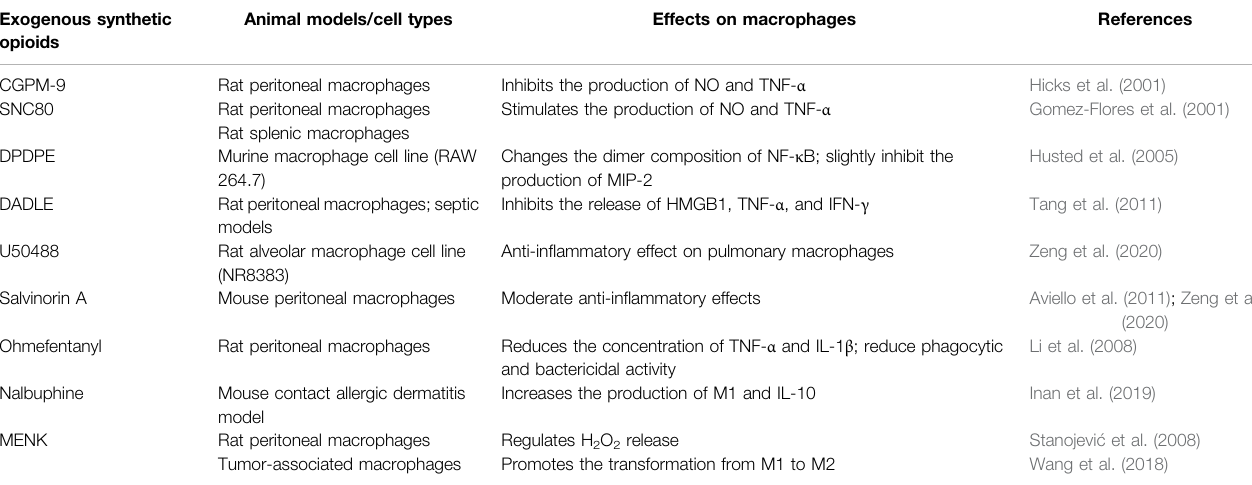
TABLE 4 | The effects of exogenous synthetic opioids on macrophage ’ s